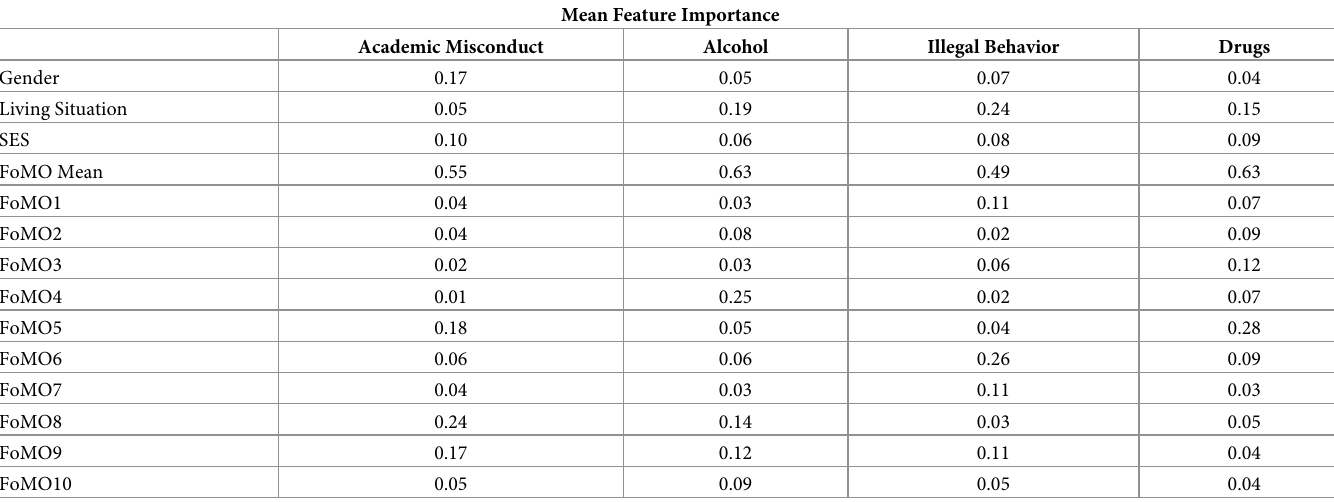
gal Behavior (0.49). Of the 3 non-FoMO variables, Living Situation carries the highest predictive value for all target variables except for Academic Misconduct (score = 0.03). Table 5. Mean feature importance scores across behaviors.